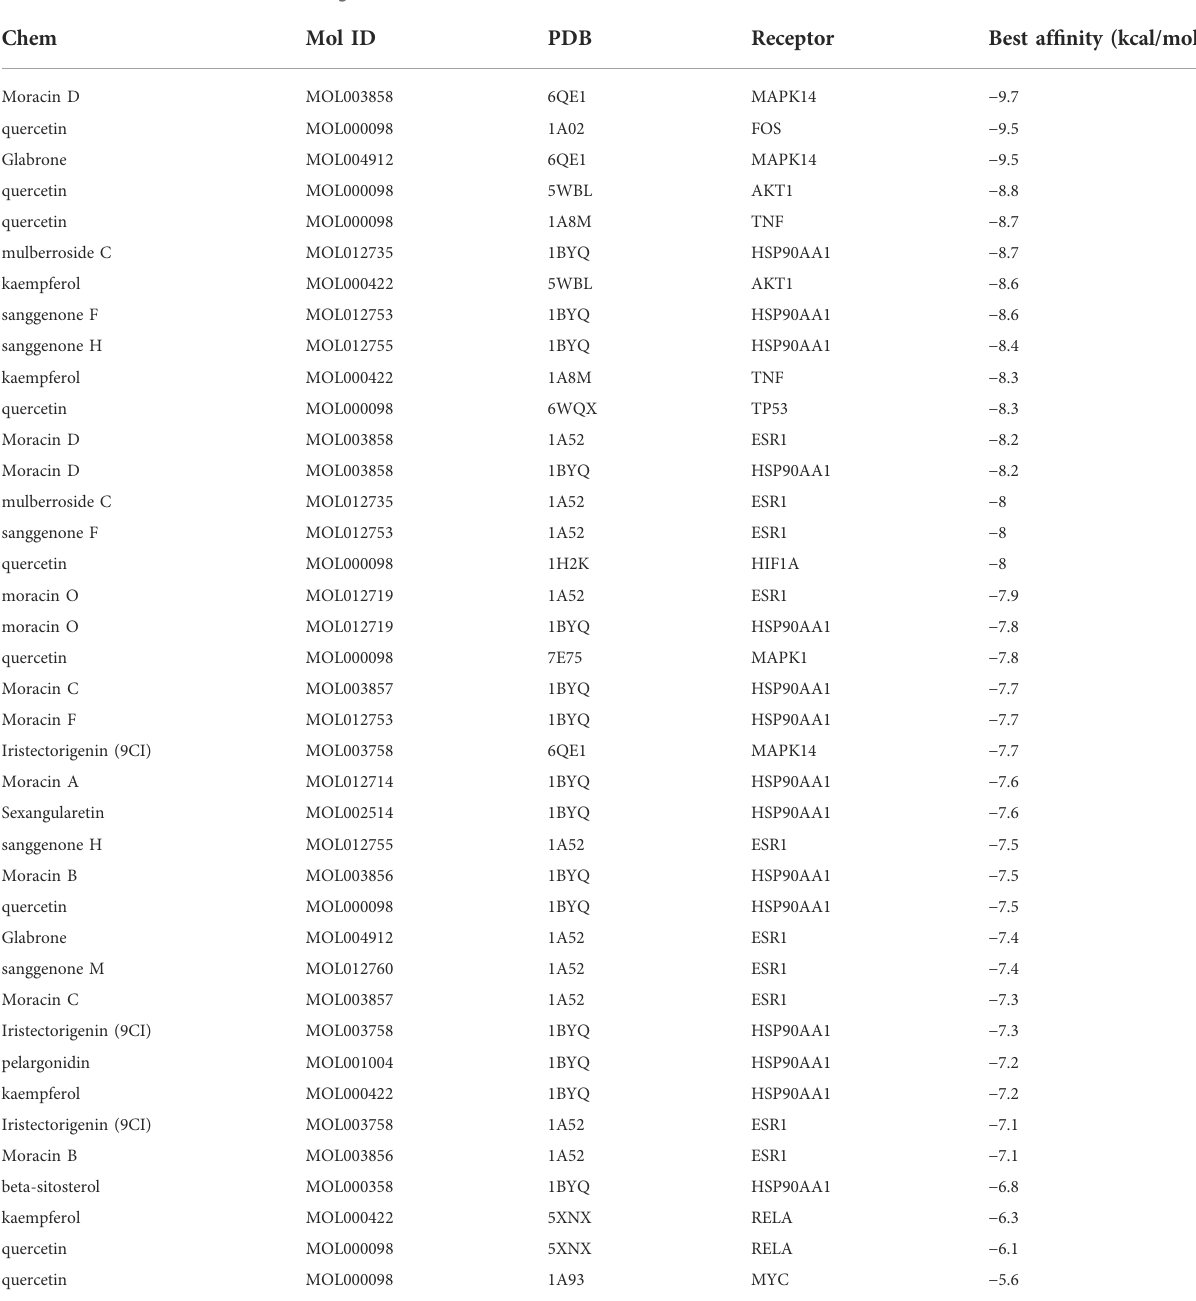
TABLE 3 The results of molecular